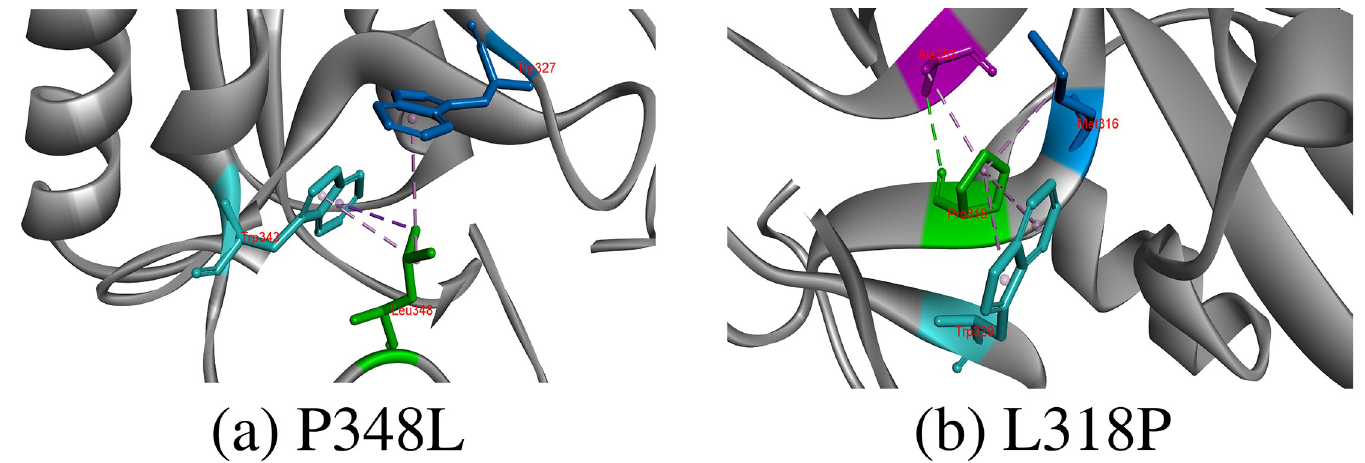
Fig 6. Hydrogen bonds, hydrophobic and electrostatic interaction of substituted amino acids at 318 and 348 positions.